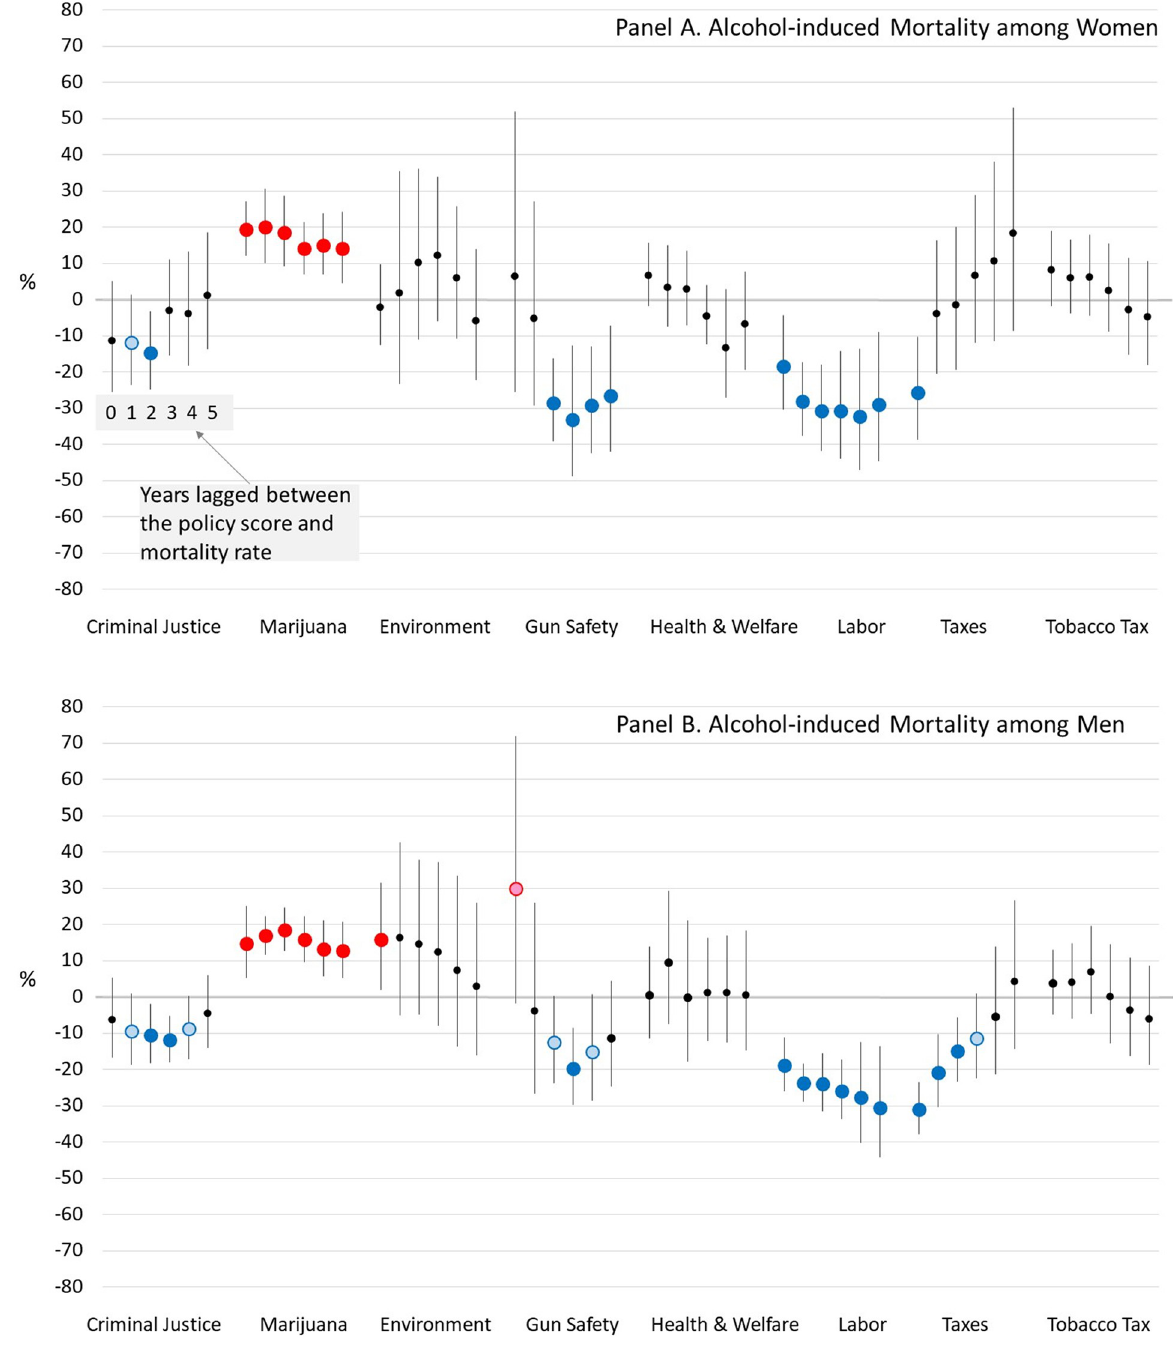
Fig 4. Estimated percent difference in alcohol-induced mortality rates when a U.S. State’s policy liberalism score is 1 versus 0, for various lag times between the policies and mortality. Notes : Blue dots mean a more liberal version of the policy is associated with lower mortality and red dots mean a more conservative version is associated with lower mortality. Dark blue and red dots indicate that the association is significant at α < 0.05, while light blue and red dots indicate that it is significant at α < 0.10.